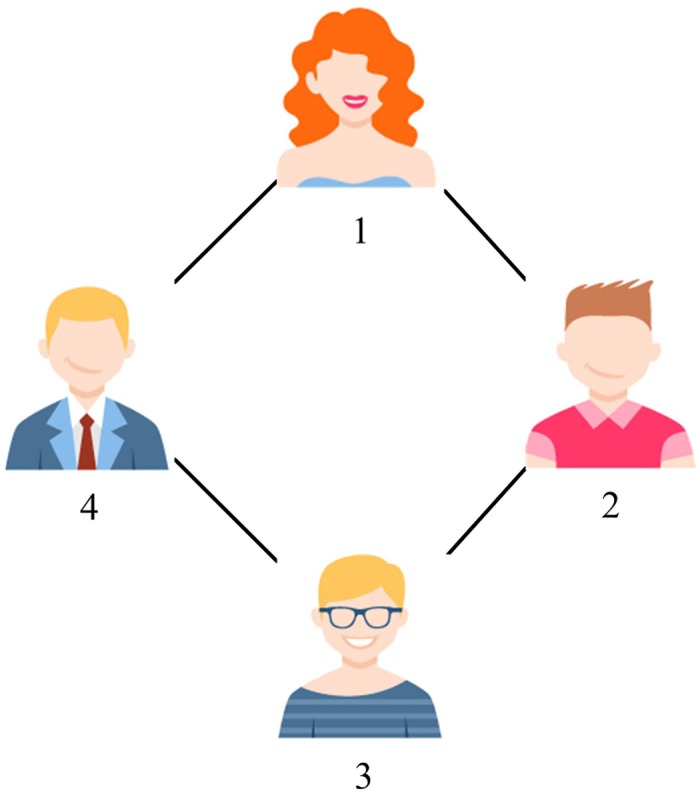
Example of similarity (a).